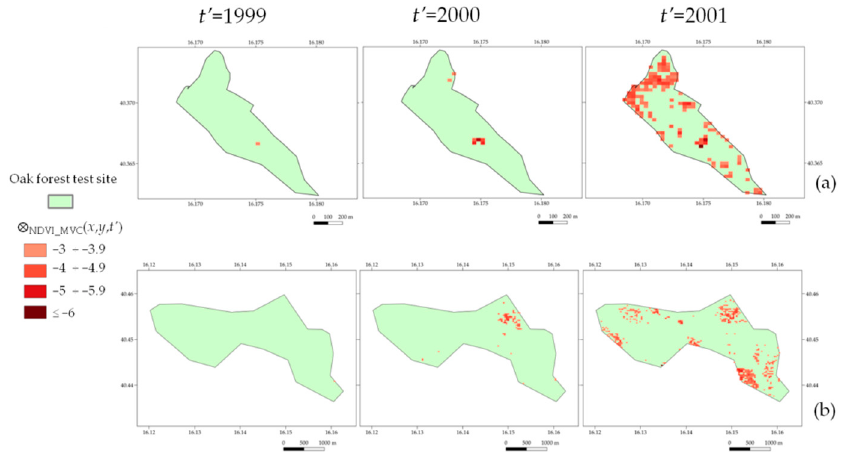
Figure 8. Spatial distribution of anomalous pixels, from less intense ( − 3.9 ≤ ⨂ NDVI_MVC ( x , y , t ′ ) ≤ − 3) to stronger ( ⨂ NDVI_MVC ( x , y , t ′ ) ≤ − 6) anomalies, in the D forest of Gorgoglione ( a ) and the ND forest of Accettura-Pietrapertosa ( b ), showing the increase in extension and anomaly intensity from 1999 to 2001. At the scale of the Basilicata region, the RST-based analysis (Figure 9) highlights that: